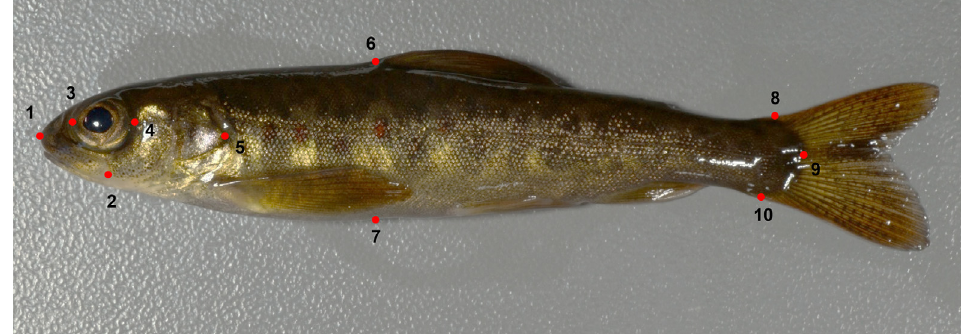
Fig. 2. Location and numbering of morphometric landmarks used for generalized Procrustes analysis of Atlantic salmon. Land- marks are a subset of those described by Winans (1984): (1) point of snout on upper jaw, (2) most posterior point of maxillary, (6) origin of dorsal fin, (8) anterior attachment of dorsal membrane from caudal fin, (9) base of middle caudal rays, and (10) anterior attachment of ventral membrane from caudal fin; in addition to a subset of those described by Fleming et al. (1994): (3) most anterior point of eye orbit, and (7) point directly below anterior dorsal fin origin on ventral body surface. Two additional landmarks were also included: (4) most posterior point of eye orbit, and (5) most posterior point of